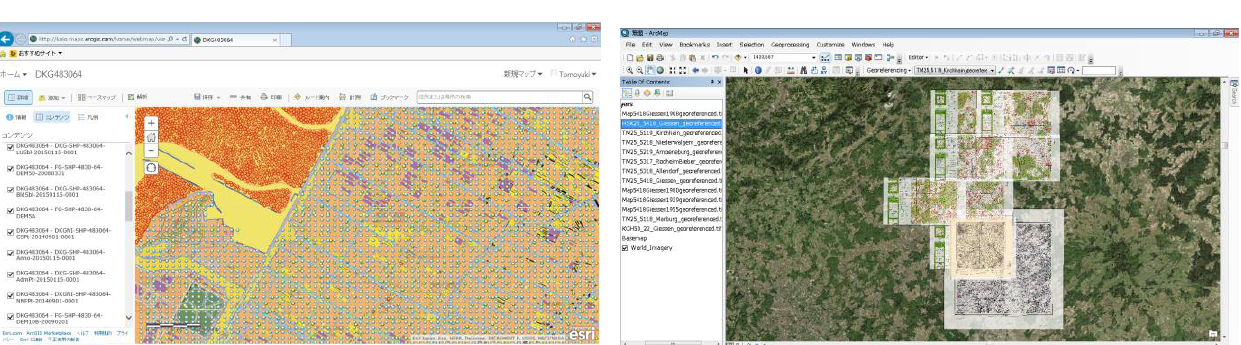
Figure 15. Digital Information by GSI (national large scale map)